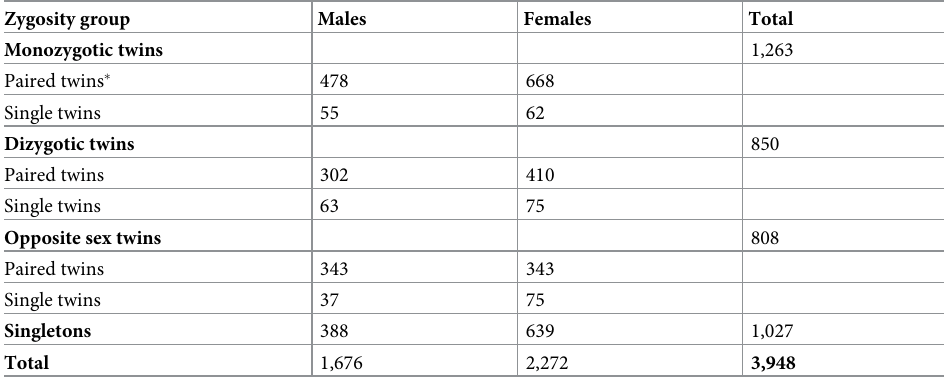
Table 1. Number of individuals per sex and zygosity.